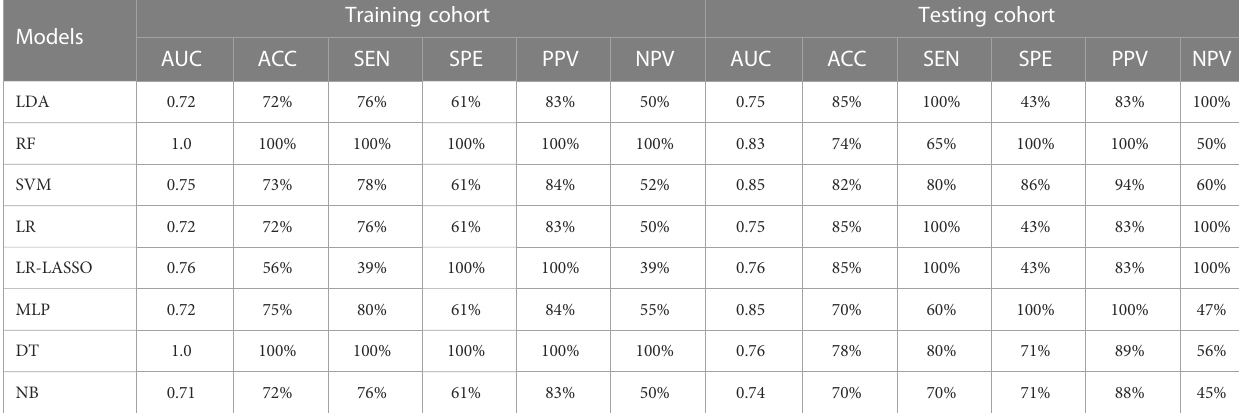
TABLE 2 Predictive performance for LDA, RF, SVM, LR, LR-LASSO, MLP, DT, and NB in the training and testing cohorts. Training cohort Testing Models